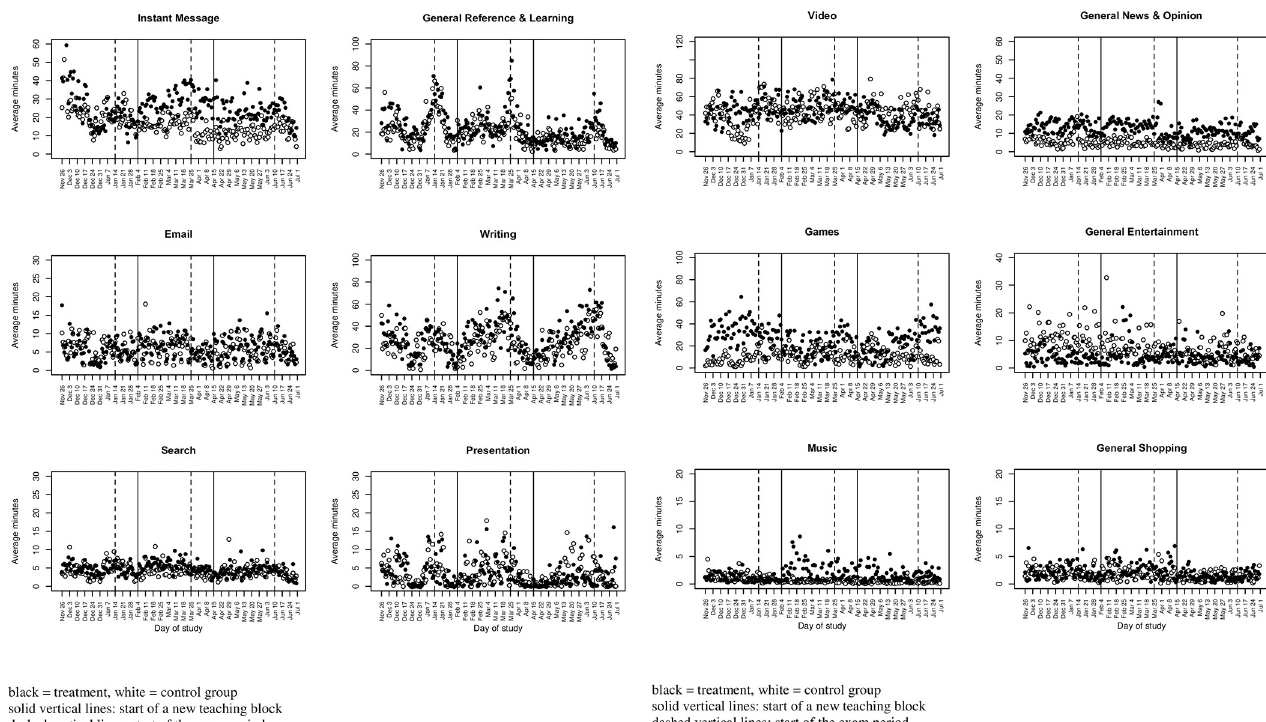
Fig 2. a. Tracked digital activities over time (users with Android devices). b. Tracked digital activities over time (users with Android devices).